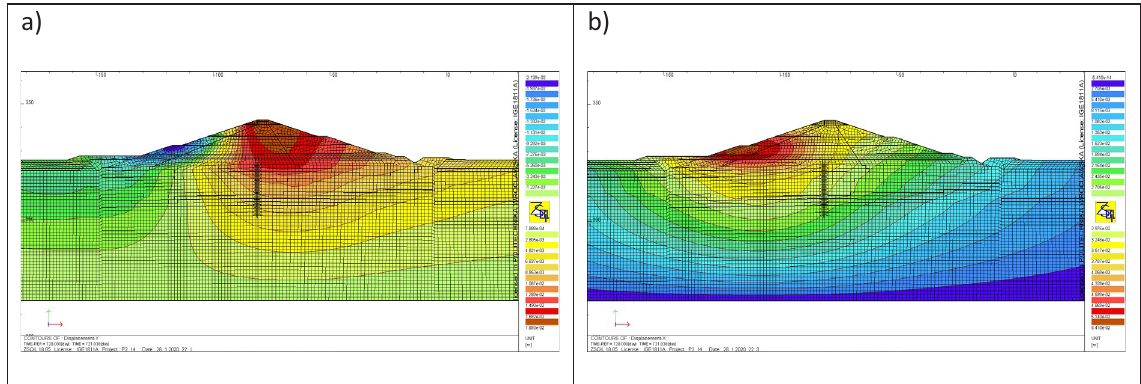
Fig. 15. Potential failure mechanisms at selected time steps of the analysis: a) for the maximum damming level, b) for the minimum FOS value.